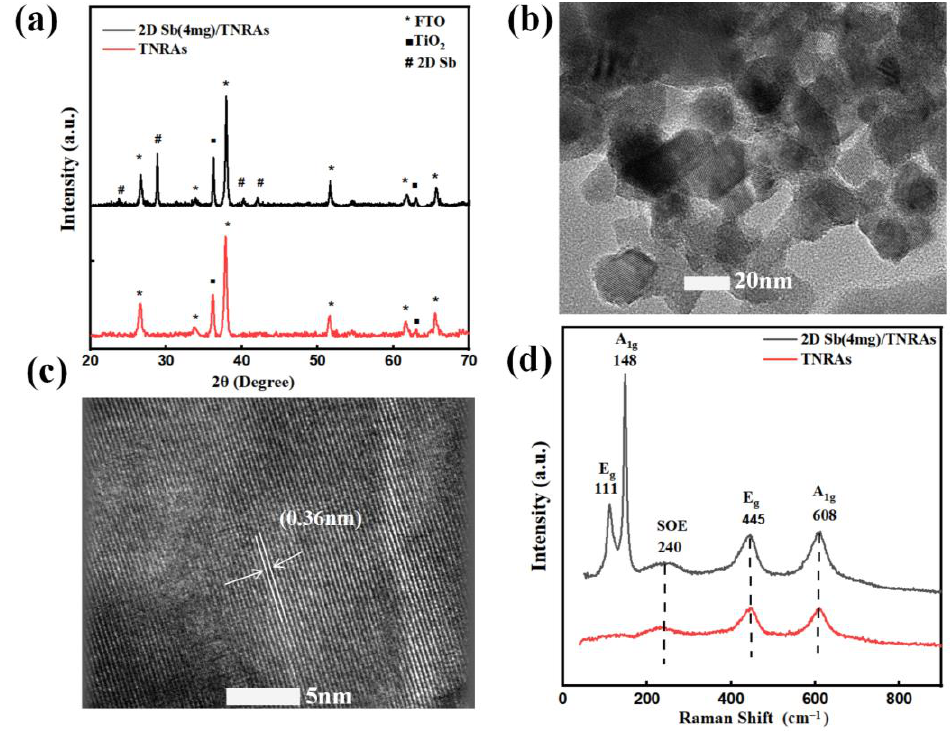
Figure 2. ( a ) XRD patterns and ( d ) Raman spectra of 2D Sb/TiO 2 NRAs. TNRAs: TiO 2 nanorod arrays. ( b ) TEM and ( c ) HRTEM images of obtained 2D Sb.